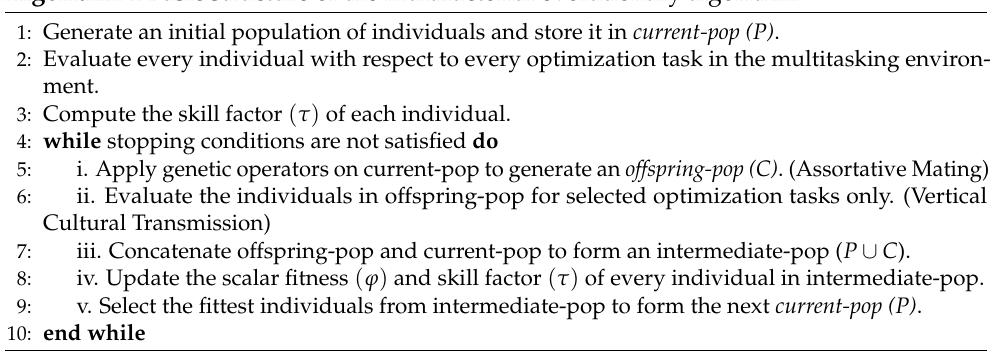
Algorithm 1 Basic structure of the multifactorial evolutionary